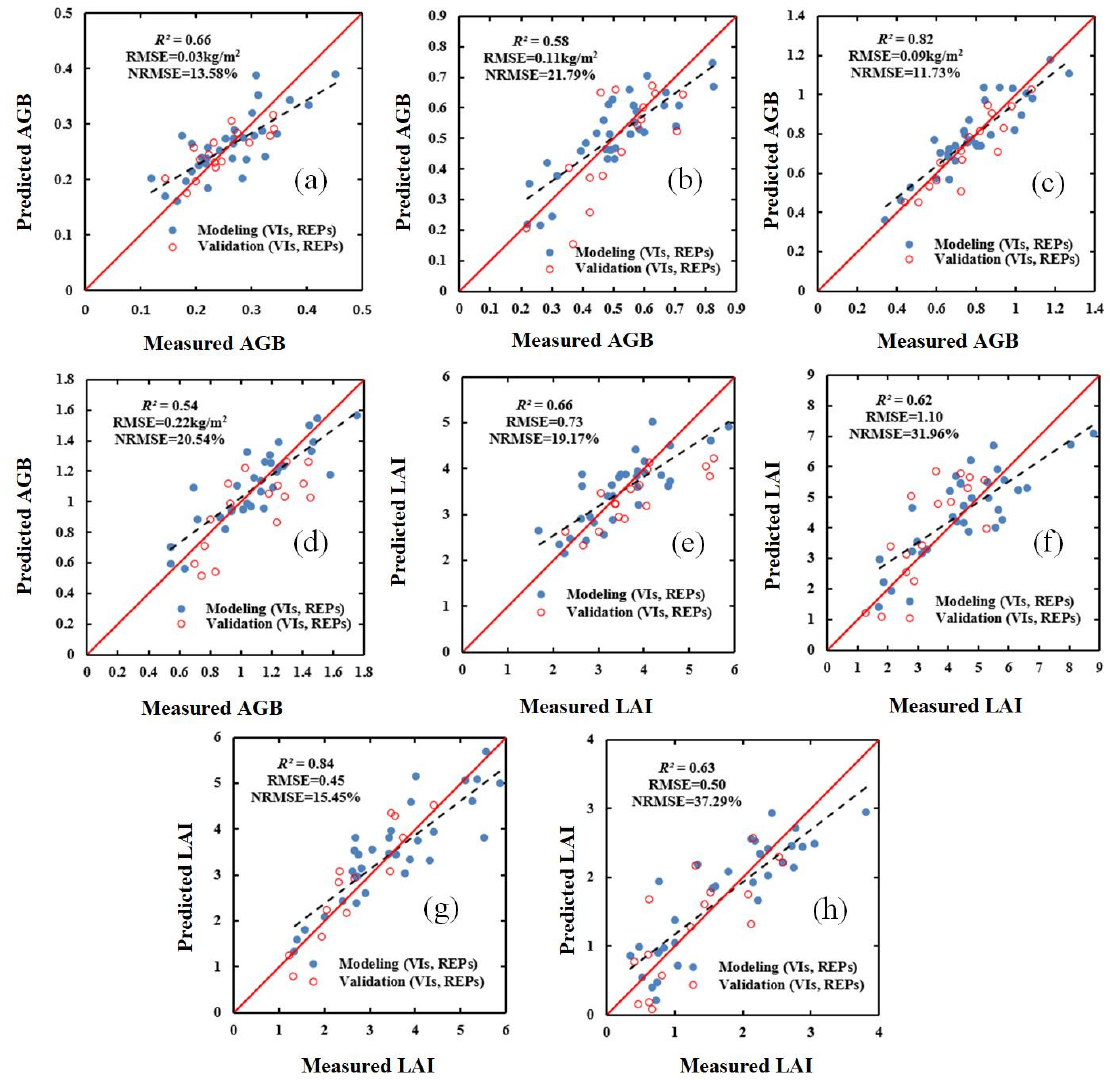
Figure 6. Relationship between ground-measured values of AGB (kg/m 2 ) and LAI (m 2 /m 2 ) in different growth stages of winter wheat and the values predicted based on a combination of VIs and RPs and PLSR: ( a ) AGB (jointing stage); ( b ) AGB (flagging stage); ( c ) AGB (flowering stage); ( d ) AGB (filling stage); ( e ) LAI (jointing stage); ( f ) LAI (flagging stage); ( g ) LAI (flowering stage); ( h ) LAI (filling stage).